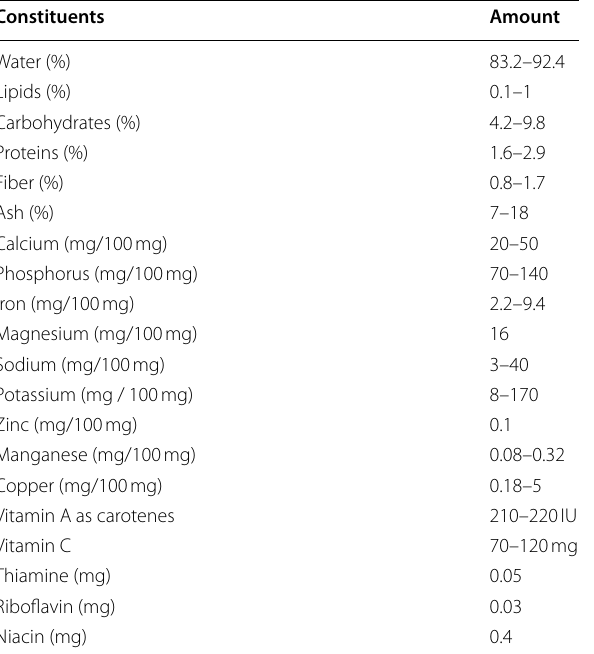
Table 1 Nutritional composition of bitter gourd (Adapted from Behera et al. 2008; Nagarani et al. 2014; Sorifa 2018; Saeed et al. 2018)